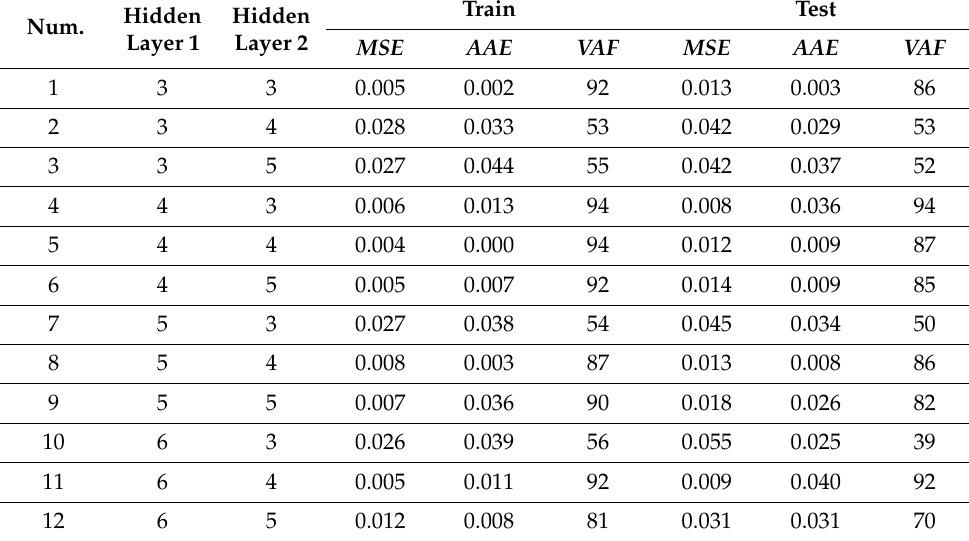
Table 6. Statistics related to 12 ANNs (the SFLA algorithm-training and testing data). Num.